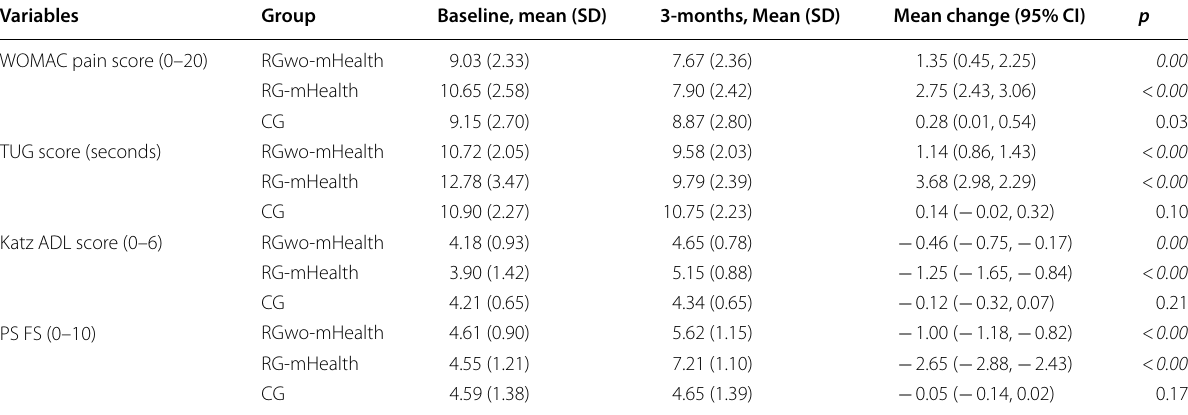
Table 4 Change in clinical outcome variables from baseline at 3-months within groups\